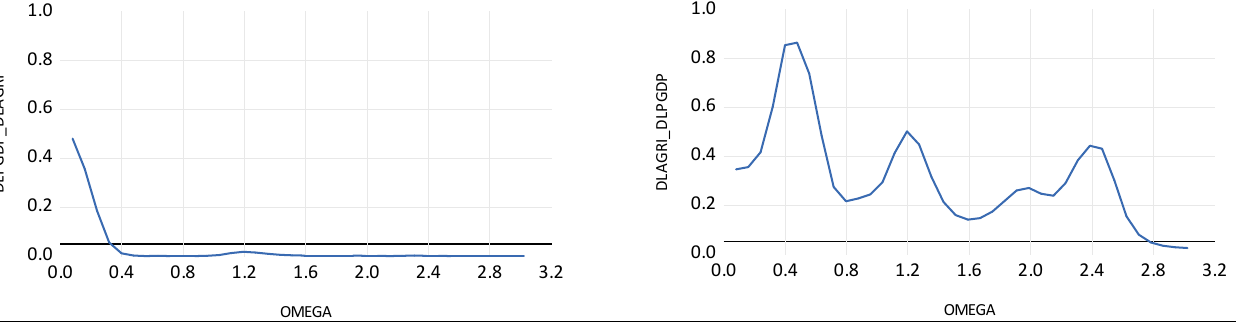
Figure 7: Causality from DLAGRI → DLPGDP in the left and from DLPGDP → DLAGRI in the right. Figure 7. Causality from DLAGRI → DLPGDP in the left and from DLPGDP → DLAGRI in the